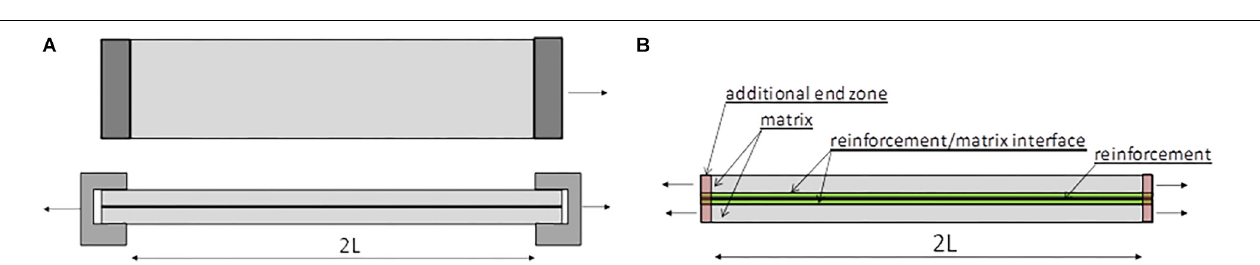
FIGURE 1 | Clamping setup configuration: (A) setup scheme; (B) scheme accounted for the modeling phase (reproduced from Grande and Milani, 2020).